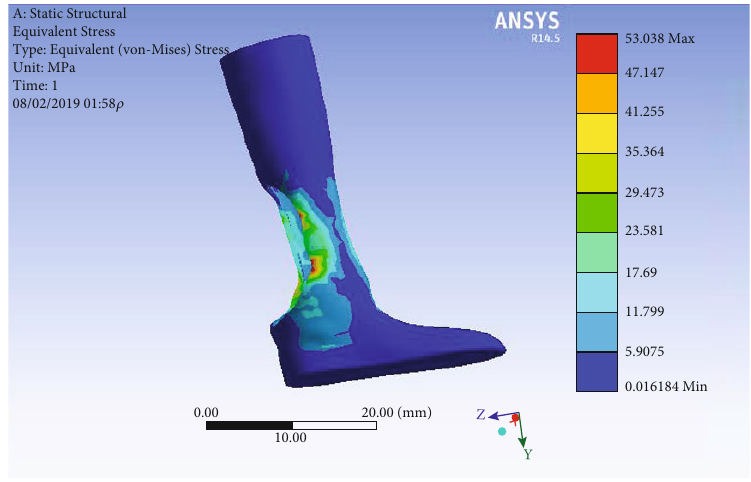
Figure 17: Equivalent stress (von Mises) in group A.